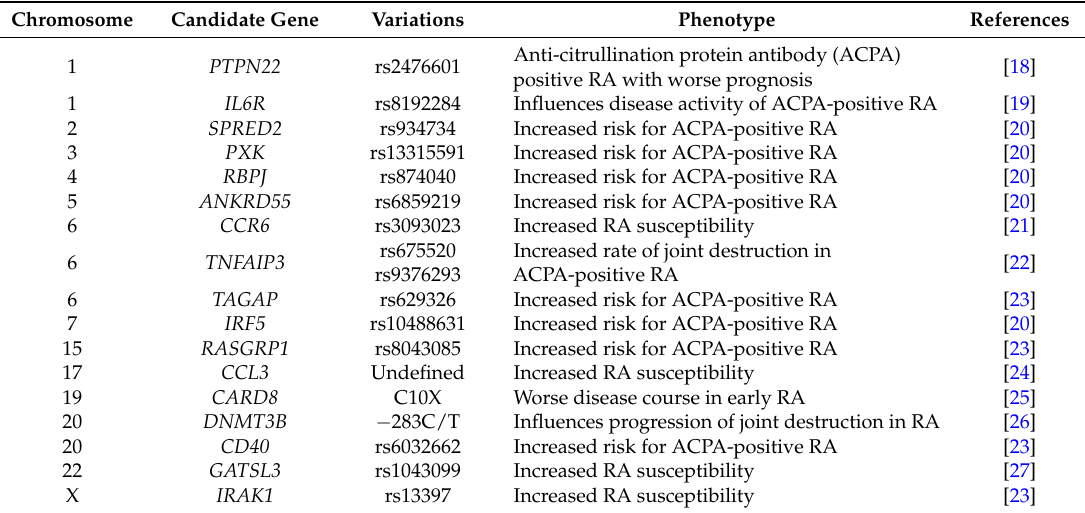
Table 2. Clinical significance of recently identified susceptibility loci in